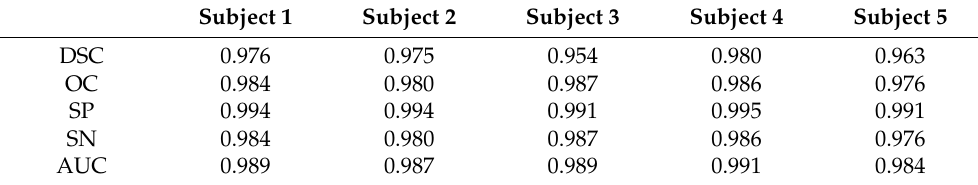
Table 5. Evaluation results for whole cerebellum segmentation without fissures (model